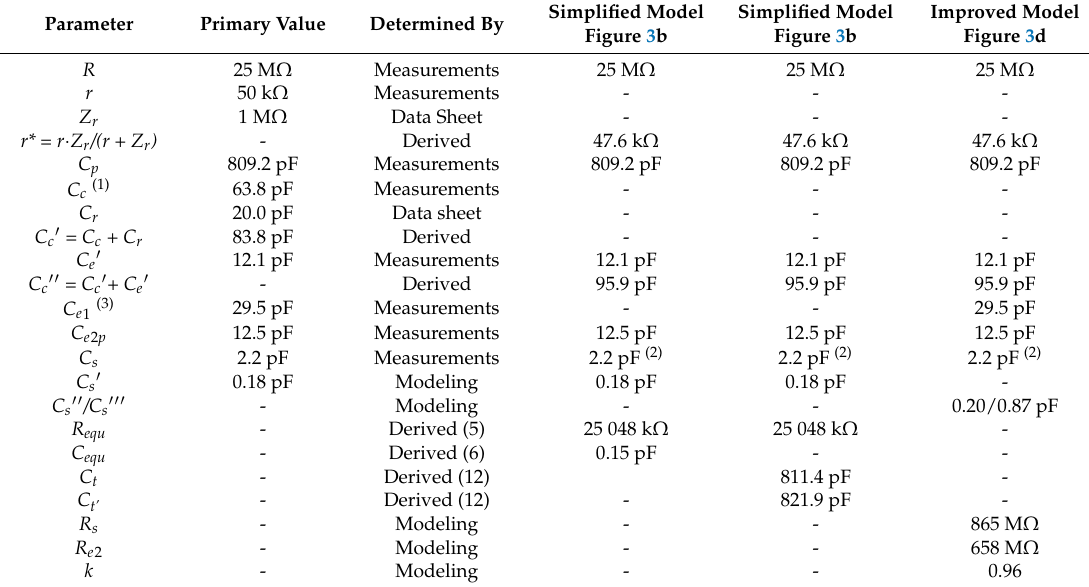
6 of 11 Table 1. Electrical parameters of the built high-voltage (HV) sensor. Parameter